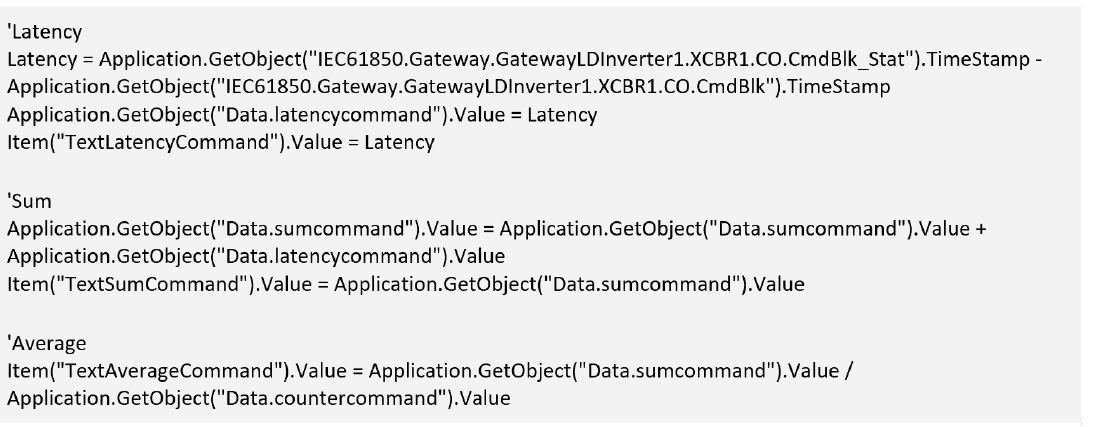
Figure 19. Latency calculation for command.